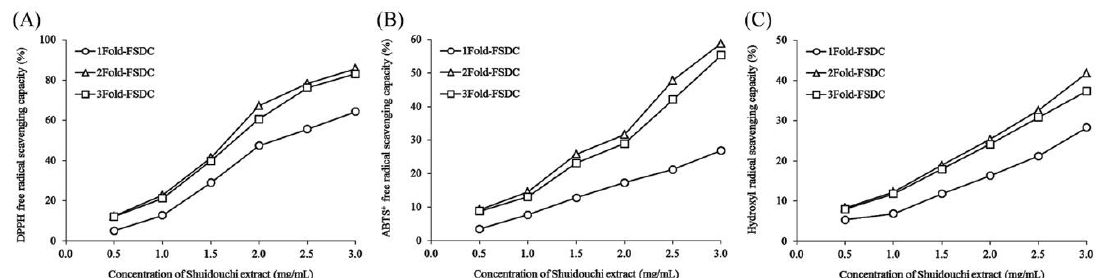
Figure 8. DPPH ( A ), ABTS + ( B ), and hydroxyl ( C ) free radical scavenging capacity of Shuidouchi at different soaking water levels. 1Fold-FSDC: 1-fold soaking water of soybeans for Shuidouchi fermentation; 2Fold-FSDC: 2-fold soaking water of soybeans for Shuidouchi fermentation; 3Fold-FSDC: 3-fold soaking water of soybeans for Shuidouchi fermentation. Table 8. DPPH (A), ABTS + (B), and hydroxyl (C) free radical scavenging capacity of Shuidouchi soaked in different amounts of water.